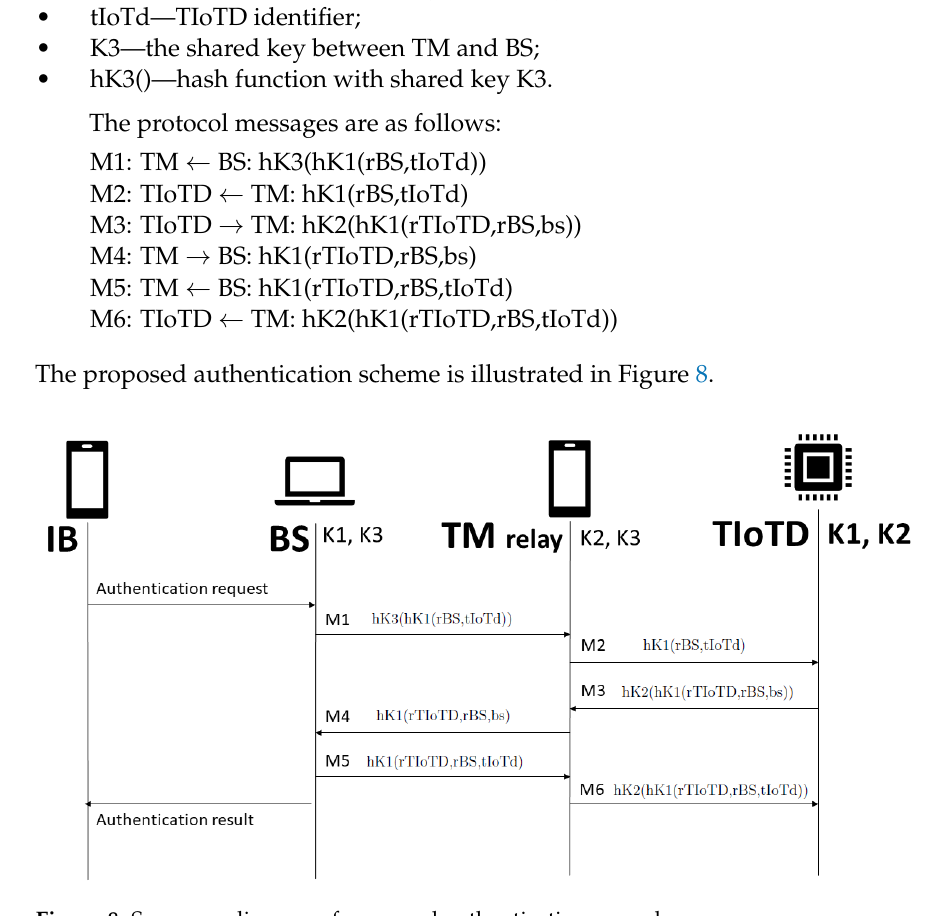
Figure 8. Sequence diagram of proposed authentication